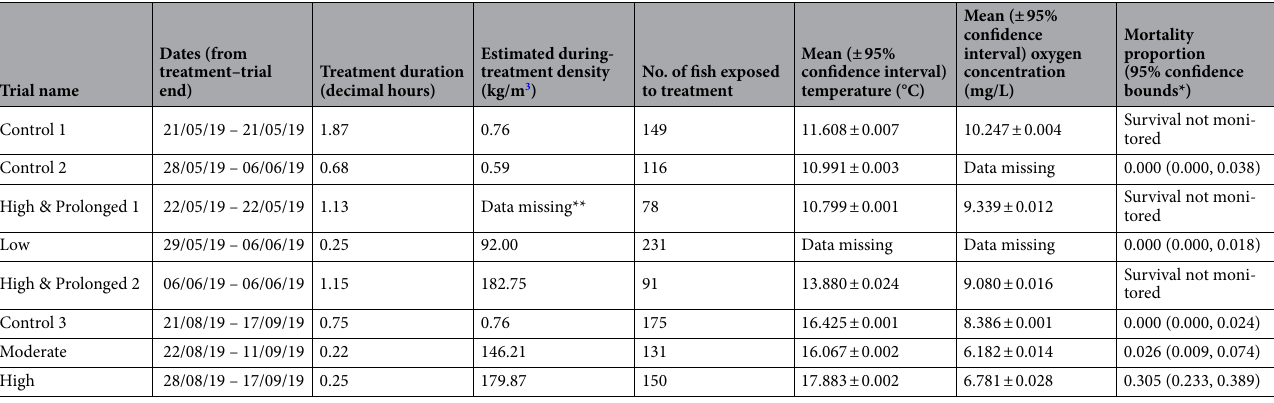
Table 1. Pertinent details of cage trials used to assess the impact of crowding on the welfare of Atlantic mackerel (Scomber scrombrus). *Calculated from Wilson score intervals. **Density assumed to be similar to the “High & Prolonged 2” trial based on qualitative